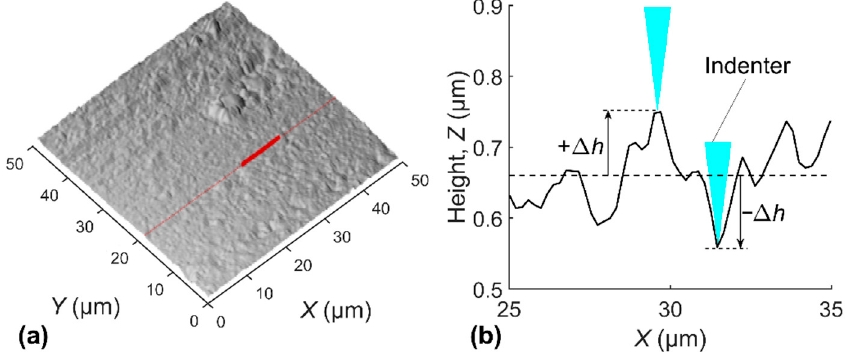
Figure 4. ( a ) AFM scan of a laboratory prepared TiO 2 acrylic paint, and ( b ) two-dimensional surface profile of the paint along the thick segment of the red line in ( a ) contacted by an indenter with a half-included angle of 70.3 ◦ , showing uncertainty in defining the contact depth on a rough surface. Note that the aspect ratio of the indenter (indicated by the blue triangles) is correctly scaled with the surface